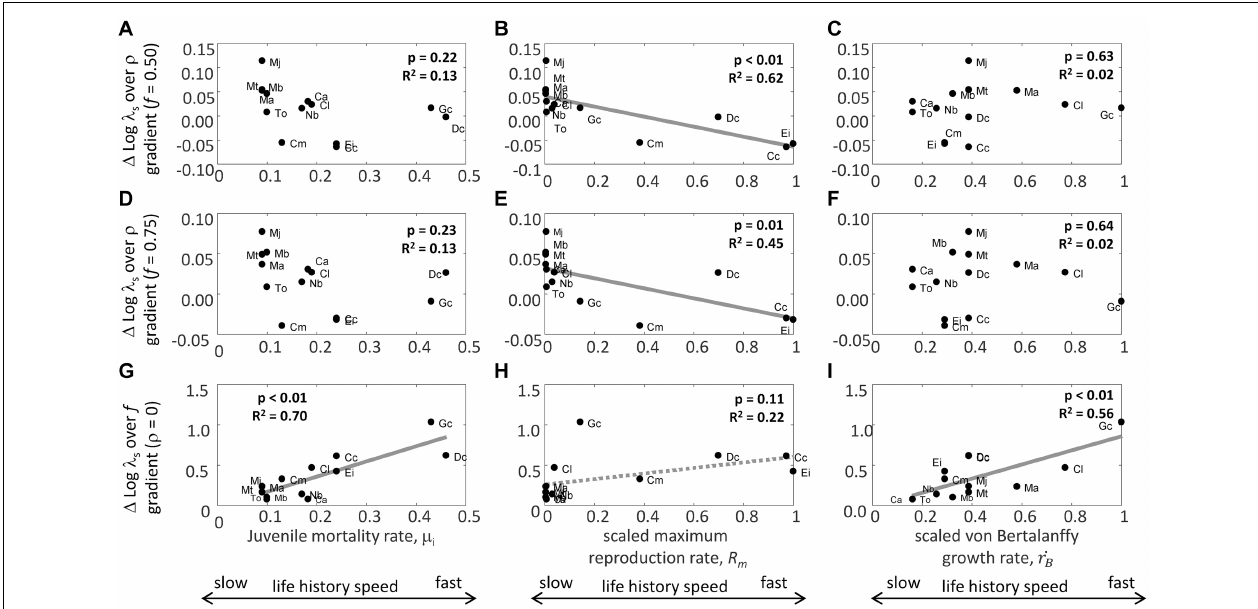
FIGURE 3 | Relationship between juvenile mortality rate, µ i (yr − 1 ) (A,D,G) , scaled maximum reproduction rate R m (# yr − 1 ), (B,E,H) , scaled von Bertalanffy growth rate, ˙ r B (yr − 1 ), (C,F,I) and the difference between the log stochastic population growth rate, log( λ s ), at the end and beginning of the environmental autocorrelation ρ gradient with good environment frequency f = 0.50 (A–C) , the difference between log( λ s ) at the end and beginning of the environmental autocorrelation ρ gradient with f = 0.75, (D–F) , and the difference between log( λ s ) at the end and beginning of the good environment frequency f gradient (with ρ = 0; G–I ). P -values and R 2 values are indicated for each relationship in each panel, with significant relationships plotted (note: H indicates a non-significant trend). Abbreviations are Mobulid species M. alfredi (Ma), M. birostris (Mb), M. japonica (Mj), and M. thurstoni (Mj); carcharhinid species C. limbatus (Cl), T. obesus (To), C. amblyrhynchos (Ca), N. brevirostris (Nb), and G. cuvier (Gc); and cheloniid species D. coriacea (Dc), C. mydas (Cm), C. caretta (Cc), and E. imbricatea (Ei). The relationship between µ i , R m and ˙ r B and the fast-slow life history speed continuum is